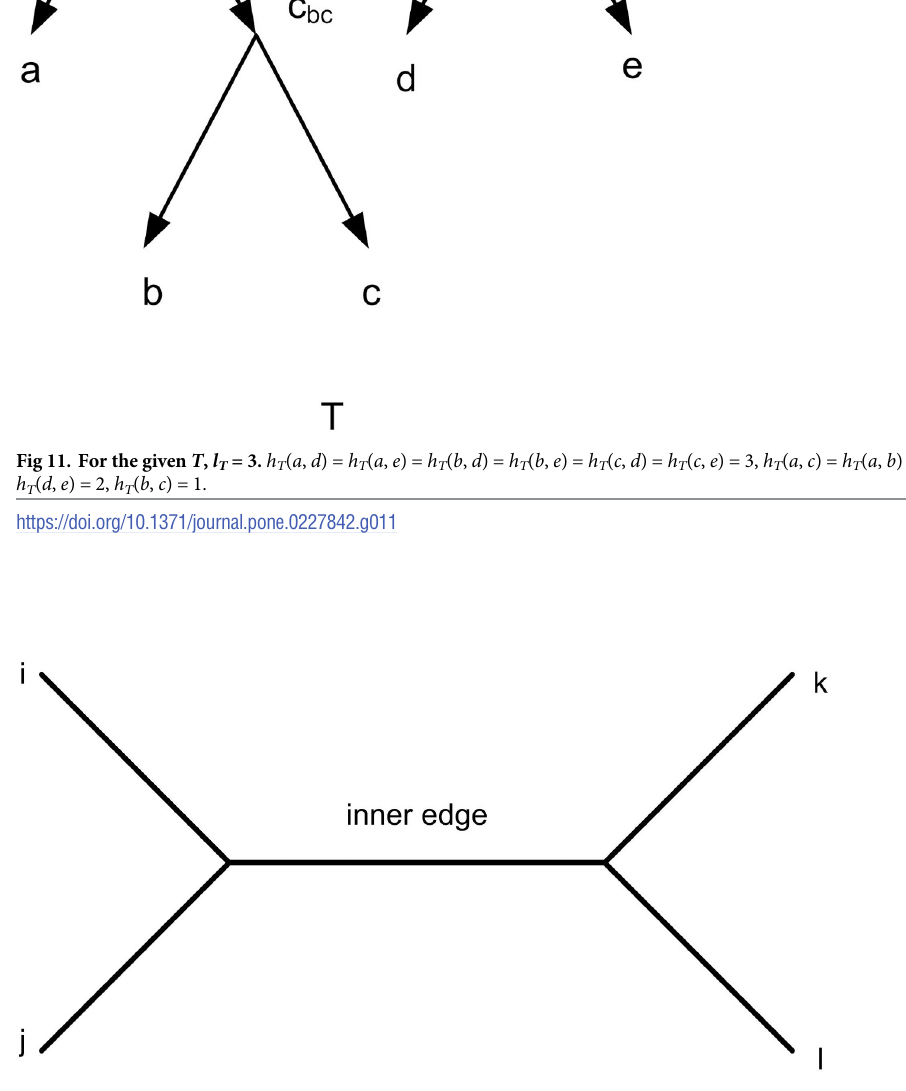
Fig 12. A quartet ij | kl with the leaves { i , j , k , l }.